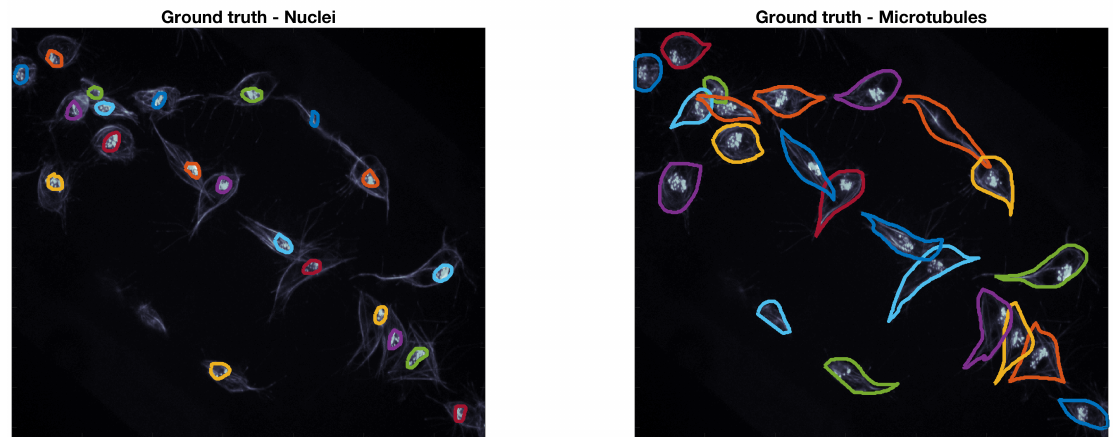
Figure 2. Example of the ground truth at a representative time frame. The ground truth for both red (nuclei) and green (microtubules) channels is shown in coloured lines. The frame is shown in grey scale to allow for a better visualisation of the lines in the ground